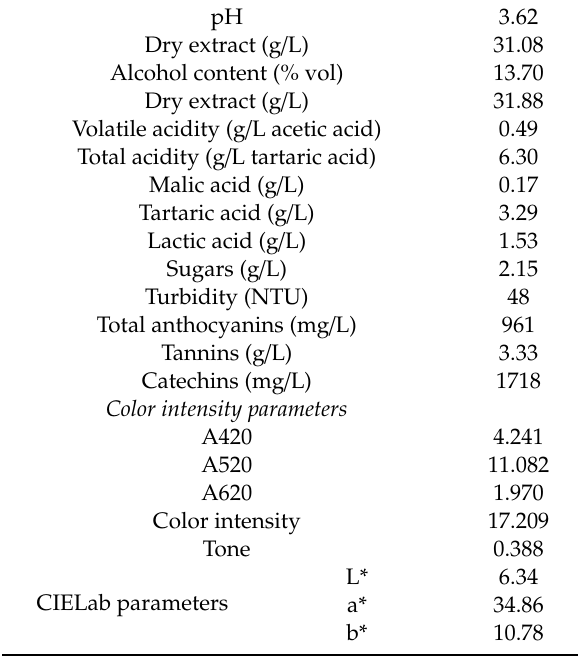
Table 1. Characteristics of base wine.